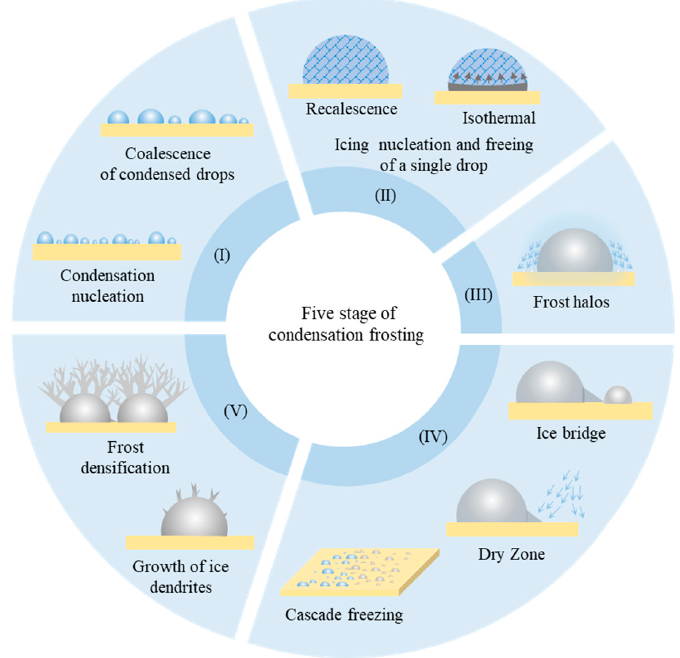
Figure 1. Five physical stages of condensation frosting.